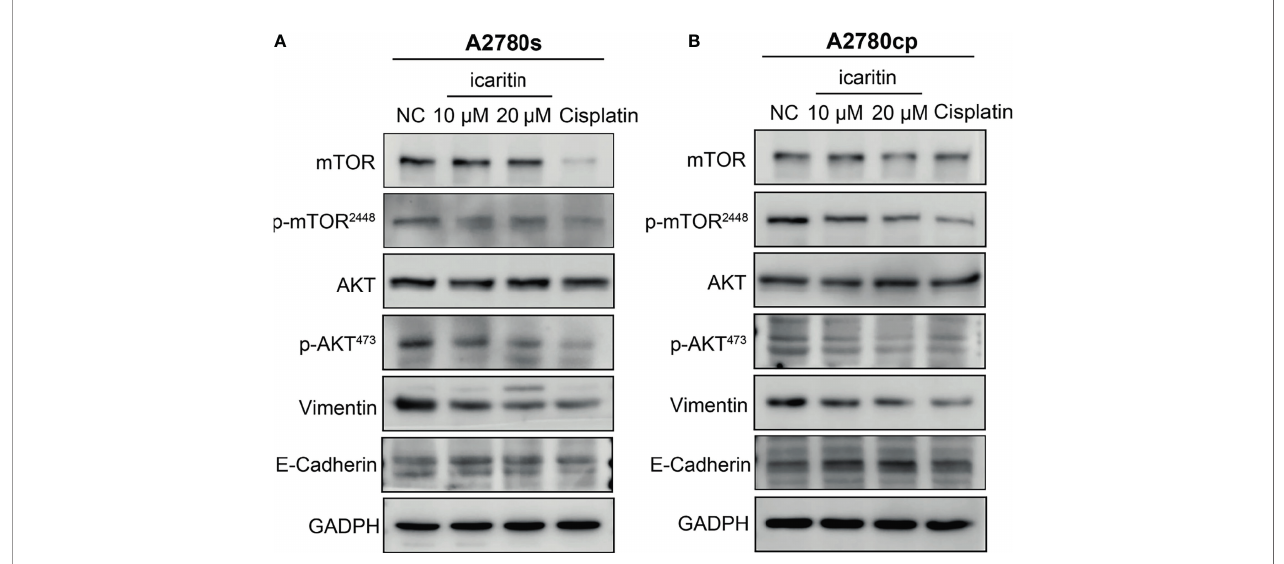
FIGURE 5 | Icaritin inhibits epithelial – mesenchymal transformation (EMT) of ovarian cancer (OC) cells via the Akt/mTOR signaling pathways. (A) Icaritin decreased the phosphorylation levels of Akt and mTOR, and the expression of vimentin, accompanied by increased expression of E-cadherin in A2780s cells. (B) Icaritin decreased the phosphorylation levels of Akt and mTOR, and the expression of vimentin, accompanied by increased expression of E-cadherin in A2780cp